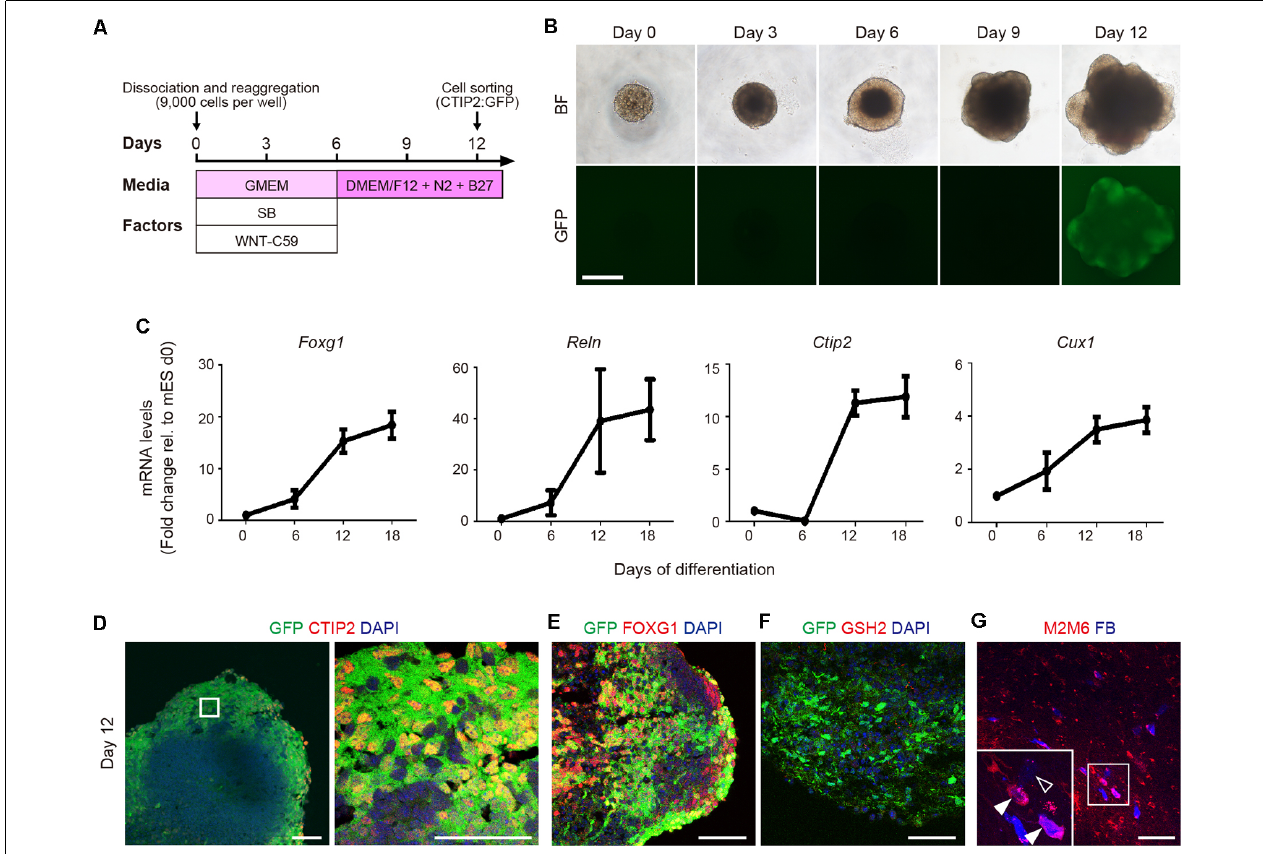
FIGURE 2 | Mouse ESC-derived CTIP2:GFP + cells show characteristics of CSMNs. (A) Schematic diagram of the cortical differentiation protocol from mouse embryonic stem cells (mESCs). (B) Bright-field and CTIP2:GFP images of the floating culture of cell aggregates from day 0 to day 12. The GFP signal is detected from day 12 onwards. Scale bar represents 500 µ m. (C) Gene expression analysis for Foxg1, Reln, Ctip2 and Cux1 by qRT-PCR ( n = 4). All values are displayed as means ± SEM. (D–F) Immunofluorescence images of CTIP2:GFP KI mESC aggregates for GFP (green), CTIP2 (red), FOXG1 (red), GSH2 (red) and DAPI (blue) on day 12. Scale bars represent 50 µ m. (G) Immunofluorescence image of a graft stained with anti-M2/M6 (red) antibodies. FB (blue) shows host cells (M2M6 - /FB + , open arrowhead) and graft-derived cells (M2M6 + /FB + , filled arrowhead). Scale bar represents 100 µ